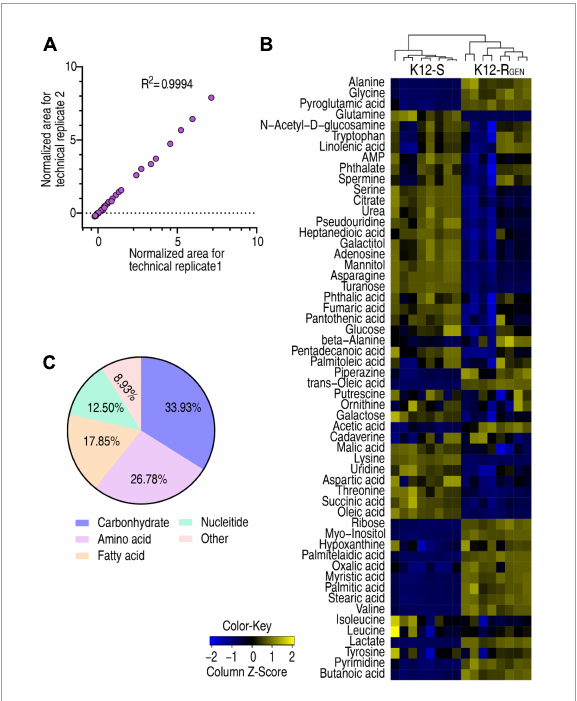
FIGURE2 Metabolite profiling of K12-R GEN and K12-S . (A) Reproducibility of the metabolomic profiling platform used in the discovery phase. The abundance of metabolites quantified in samples over two technical replicates is shown. The Pearson correlation coefficient between technical replicates varies between 0.9946 and 0.9995. (B) Heat map of unsupervised hierarchical clustering of different metabolites (row). Blue indicates decreases and yellow indicates an increase of the metabolites scaled to the mean and standard deviation of row metabolite level (see color scale). (C) Categories of the differential metabolites. Fifty-six differential abundances of metabolites are searched against in KEGG for categories. The pie chart is generated in Excel 2010 (Microsoft,